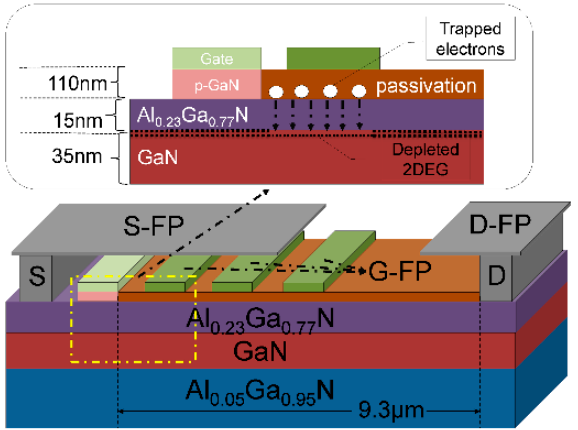
Figure 15. HEMT with a micro field plate (micro-FP) structure. Reprinted with permission from ref. [198]. Copyright 2021 MDPI.